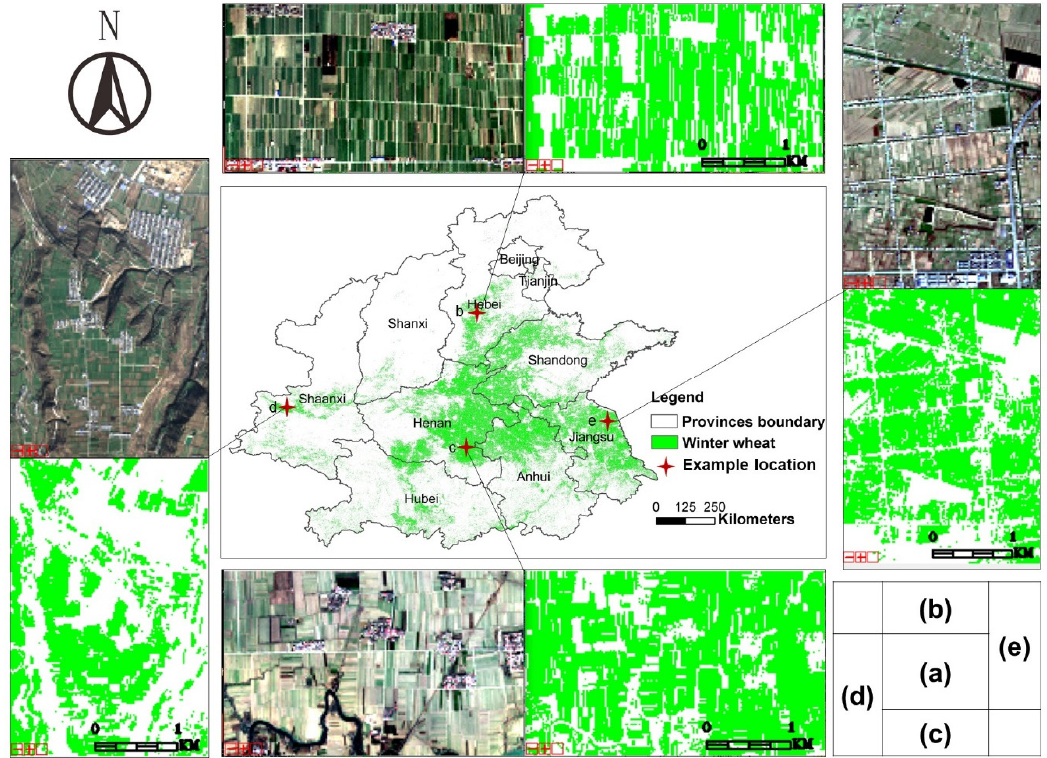
Figure 10. ( a ) Winter wheat map of North China in 2017–2018 derived from Sentinel 2 images with the PT-DTW method. ( b – e ) The sentinel-2 RGB images in December and the zoomed in winter wheat maps of four example locations from Hebei, Henan, Shaanxi and Jiangsu provinces.